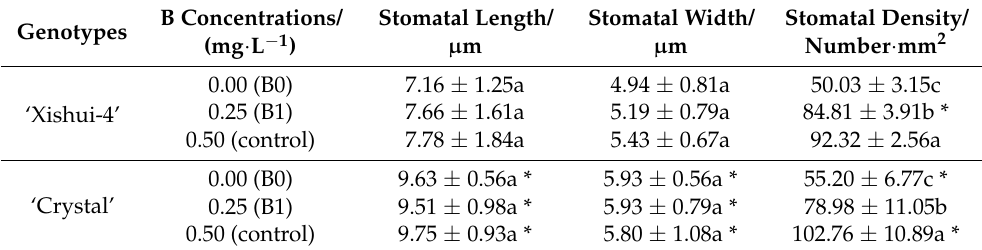
Table 5. Effects of B-deficiency on the stomata characteristic of two grape